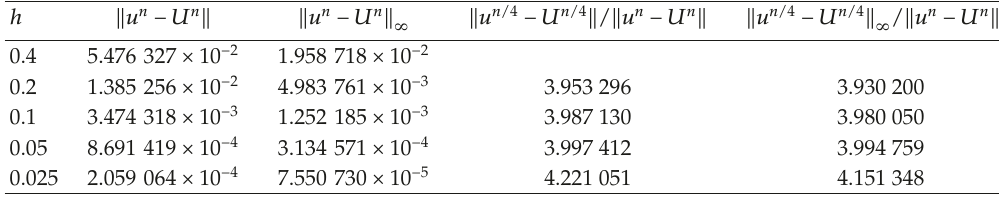
Table 1: The errors of numerical solutions at t (cid:7) 60 with τ (cid:7) h for p (cid:7) 2.